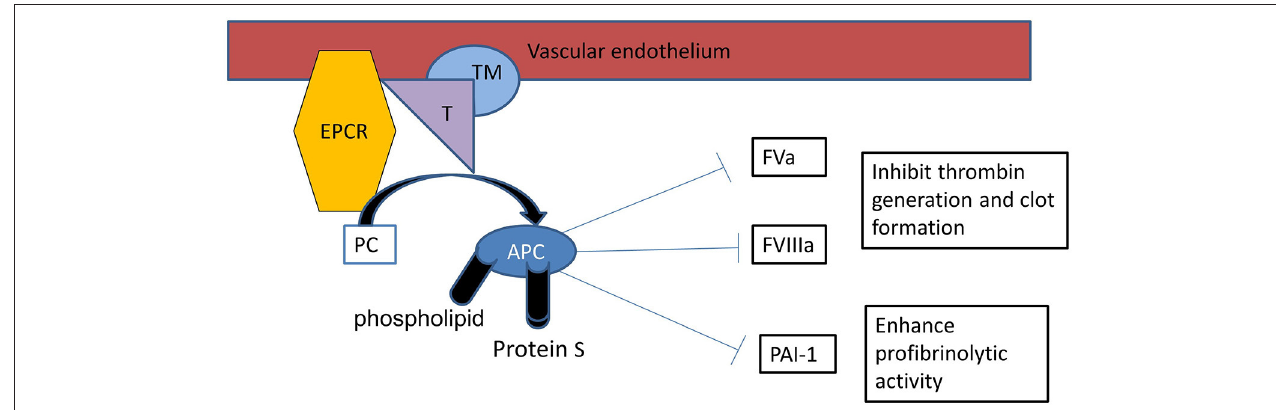
FIGURE 1 | Protein C activation: Protein C binds with thrombin (T)-thrombomodulin (TM) complex on endothelial surface with it is receptor endothelial protein C receptor (EPCR), resulting in activation of protein C (APC). APC proteolytically inactivates FVa and FVIIIa, therefore APC is an important inhibitor of the clotting